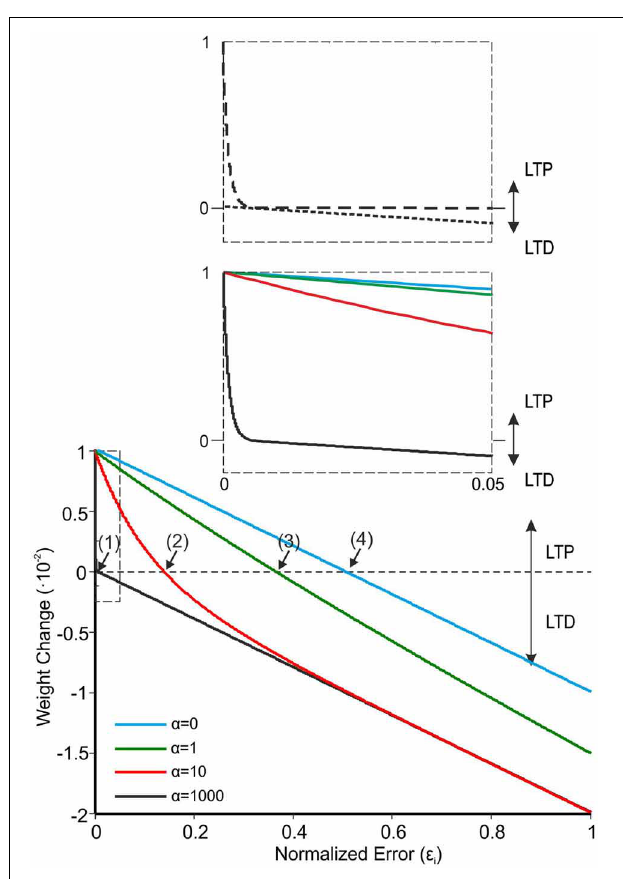
FIGURE 3 | The learning rule for PF-PC plasticity. Comparison of four different α values in Equation 3 (LTP Max and LTD Max were set at 0.01 and 0.02). Equation 3, which represents the synaptic weight change as a function of normalized error reaching the cerebellum through the CFs, shows better learning performances at high α values (black solid line). With α = 1000, Equation 3 crosses the X -axis at a very low value (curve 1: ε i ≈ 4 . 7 · 10 − 3 ). When α is lowered, the curves cross the X -axis at progressively higher ε i values (curve 2: α = 100, ≈ 137 . 7 · 10 − 3 ; curve 3: α = 1, ε ≈ 366 · 10 − 3 ; curve 4: α = 0, ε i i ≈ 500 · 10 − 3 ). The inset shows that with α = 1000 there is a rapid ε i decrease of LTP toward zero, while the LTD evolves linearly with the